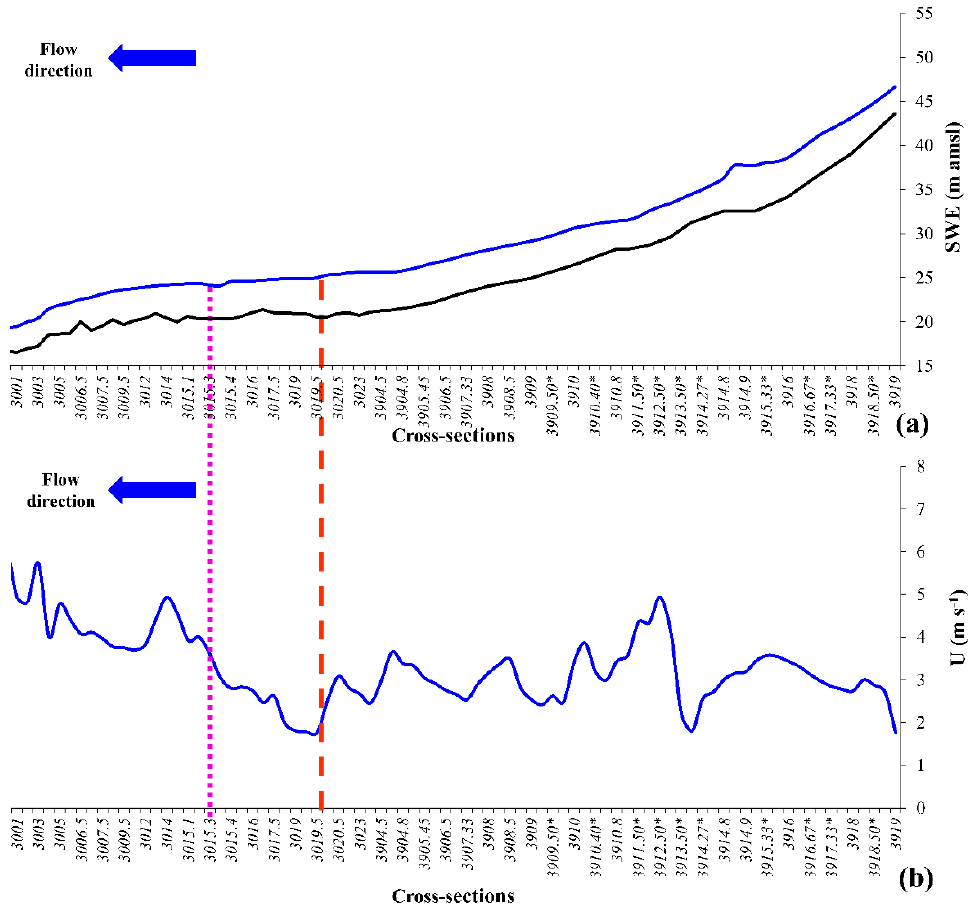
Figure 12. ( a ) Surface water elevation (SWE) and ( b ) flow average velocities U along the Morra Creek cross-sections resulting from the 2D unsteady simulation. The continuous black line represents Morra Creek bed elevation. The blue arrow indicates the flow direction, while orange dashed lines and purple dotted lines, respectively, indicate the locations of “Bridge A” and “Bridge B” cross-sections. The * in the figure is just due to the software output visualization.